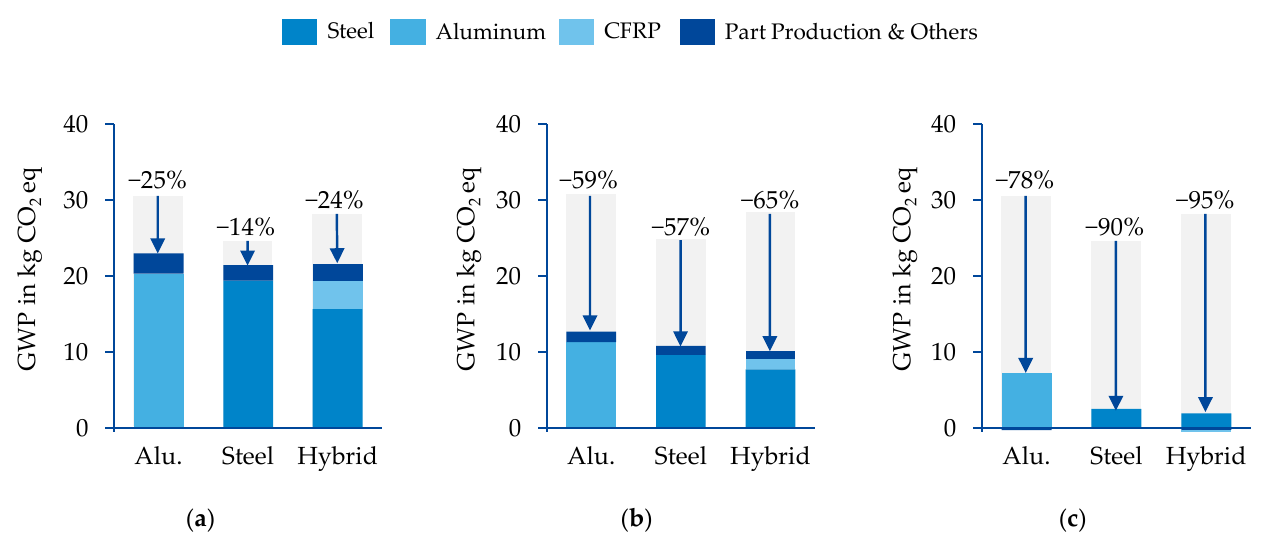
Figure 9. GWP of the three design alternatives, including material and part production in 2030 ( a ), 2040 ( b ) and 2050 ( c ) compared to the reference year 2020.